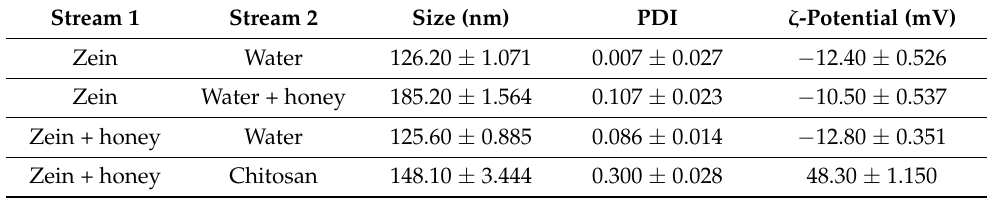
Table 2. Size, PDI and ζ -potential of the NPs. Data are presented as mean ± SEM ( n = 3). Stream